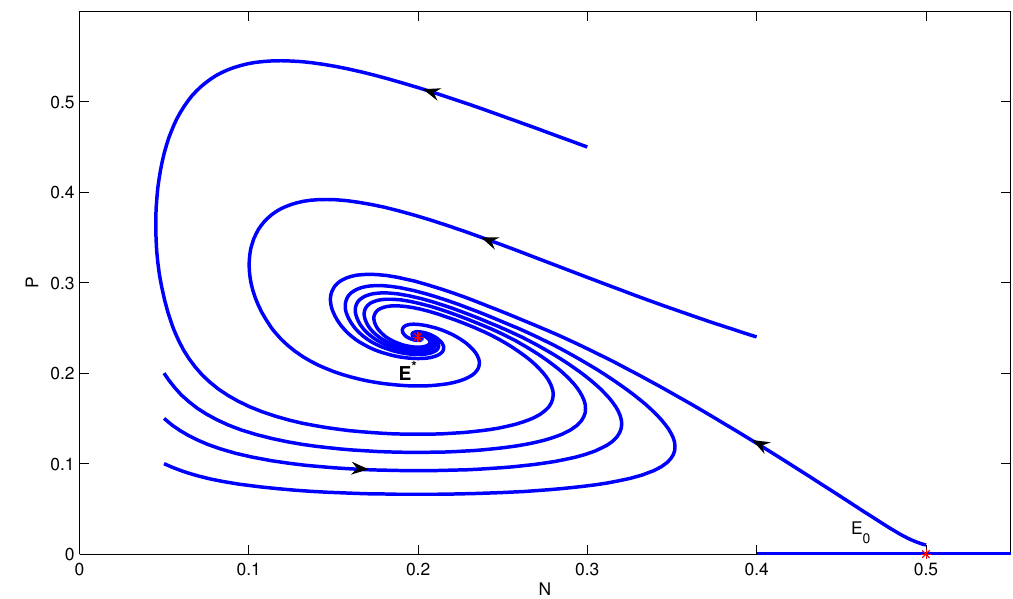
Figure 4. The phase portrait of model Equation (3) when E ∗ is globally asymptotically stable and E 0 is unstable.